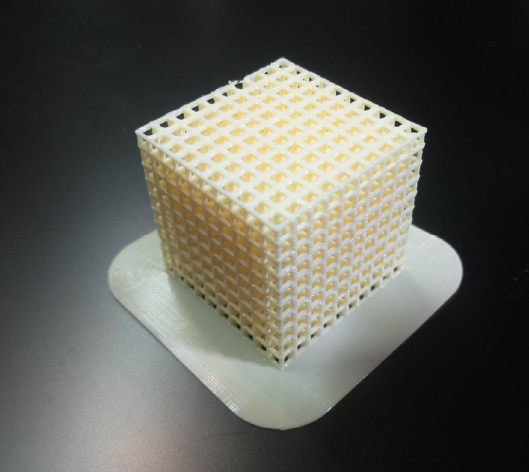
The software allows the user to adjust printing parameters for the desired effect.